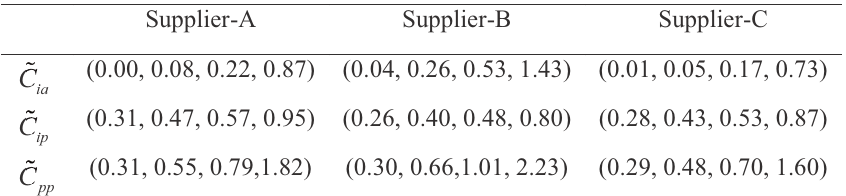
Table 5 The fuzzy indices for supplier